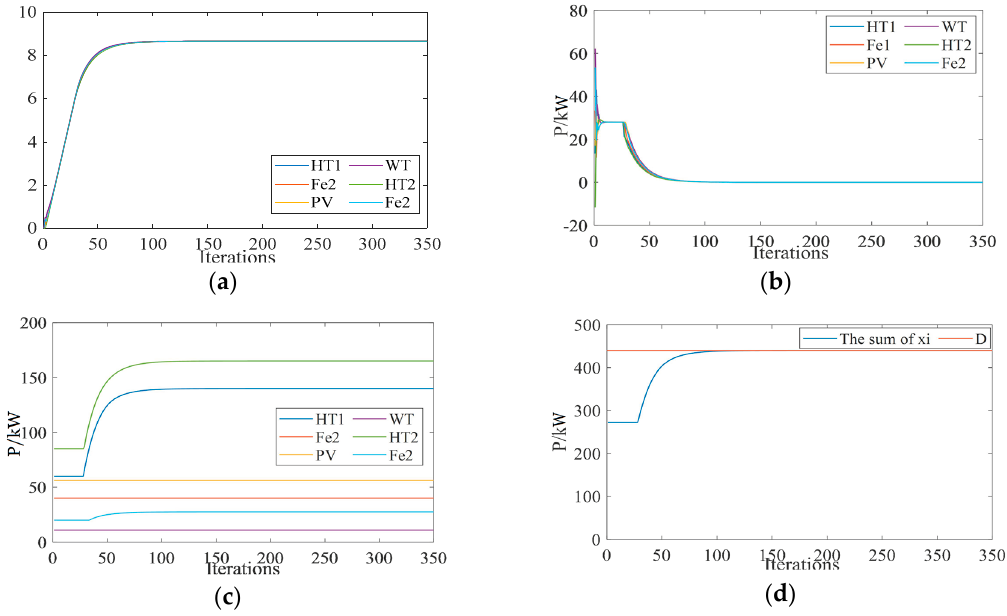
λ ( a ), Mismatch y ( b ), DGs output power x i